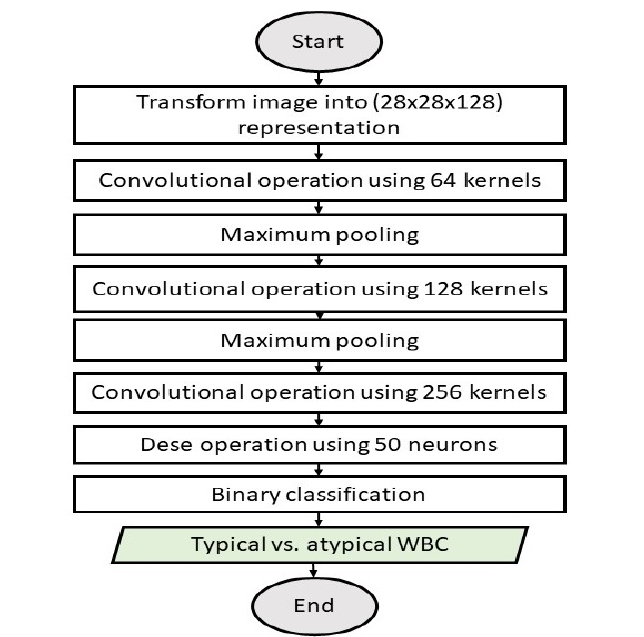
Figure 5. Stage I: Typical vs. atypical binary classification